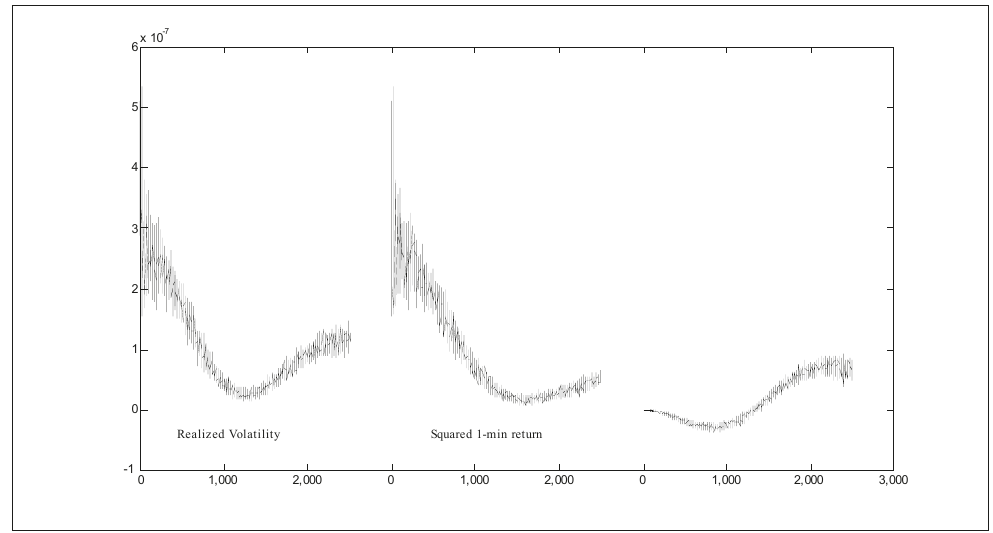
Figure 2. The periodogram of the realized volatility obtained from 1-min returns ( left ), the squared 1-min returns multiplied by 330 ( middle ), and the difference between them ( right ) for the high-frequency S&P 500 returns data. The sample period is from 7 October 1986 to 2 March 2007. Combining the equation for the squared daily returns (2) and that for the realized volatility (4), we know, as discussed in Section 3, that both the realized volatility and the squared daily returns contain the same information about long memory. However, the squared daily returns contain a larger noise component than does the realized volatility. Figure 3 shows the log squared daily return series (left), the log realized volatility obtained from 1-min return series (middle), and the difference between them (right). We can see that the log squared daily return series (left) exhibits larger variance than the log realized volatility series (middle). No pattern is seen in the difference (right), and it simply seems to be noise. Figure 4 shows the periodograms of the log squared daily returns (left) and the log realized volatility obtained from 1-min return (middle), as well as the difference between them (right). Note that the periodogram of the log squared daily returns (left) is much larger than that of the log realized volatility constructed from 1-min returns (middle) except for the first few frequencies near zero. These results are consistent with Equation (5) and with the presence of RLS given the very large values near frequency zero. For those frequencies near zero, both periodograms show very large values. Similar to what was shown in Figure 3, the difference (right) appears to be caused by a white noise process. In addition, we can see that the white noise process is dominant in the periodogram of the log squared daily return series (left). As shown in Figure 5, similar results occur for the periodograms of the log realized volatility obtained from 110-min returns (left), 30-min returns (middle) and 5-min returns (right). The periodograms exhibit smaller values when higher frequency data are used, except for the first few frequencies indices near zero. For these, the periodograms are likely determined by low-frequency contamination, for example, random level shifts (Perron and Qu 2010 and McCloskey and Perron 2013). In general, the values of the periodograms are much larger for frequency indices near zero, which can be explained by the fact that the impact of the random level shifts dominates that of the noise